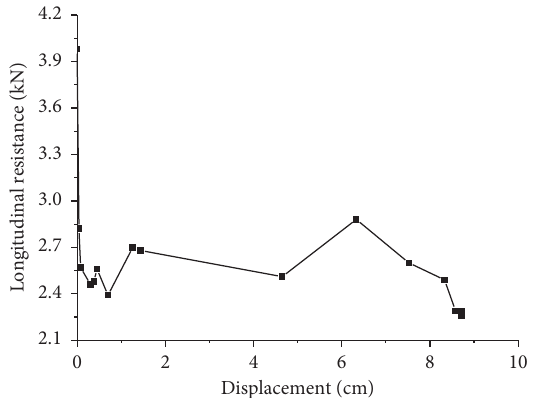
Figure 9: Relationship between longitudinal resistance and pad displacement at 0.5mm